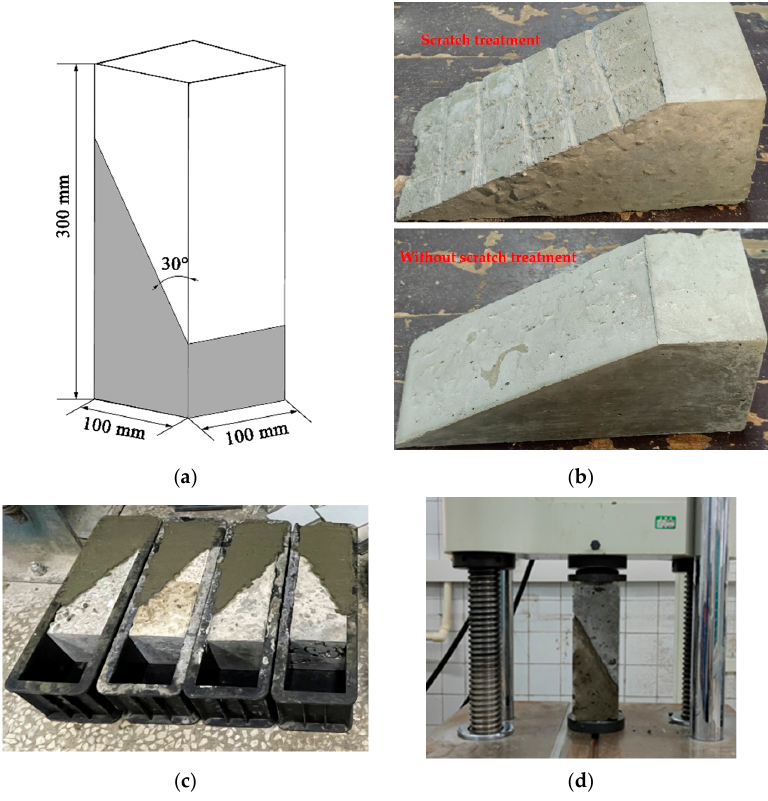
Figure 4. The slant shear test flow. ( a ) Specimen geometry; ( b ) Concrete interfacial scratching treatment; ( c ) Casting; ( d ) Loading.